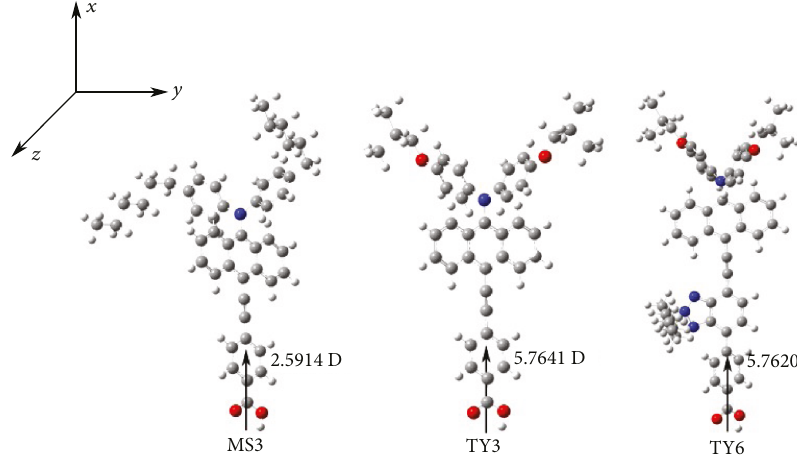
Figure 6: Calculated vertical dipole moment μ